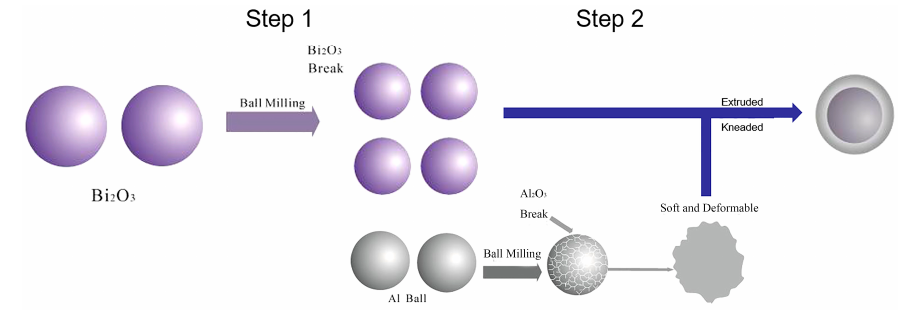
Figure 5. Ball milling process and mechanism diagram.